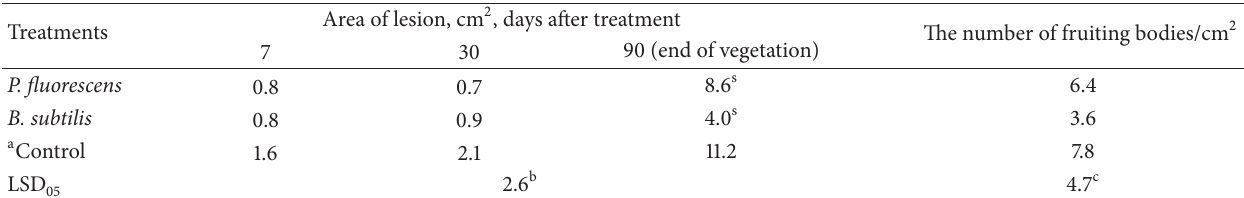
Table 4: Influence of the biocontrol agents on cane lesion due to spur blight development in cultivar Kolokolchik. Area of lesion, cm 2 , days after Treatments